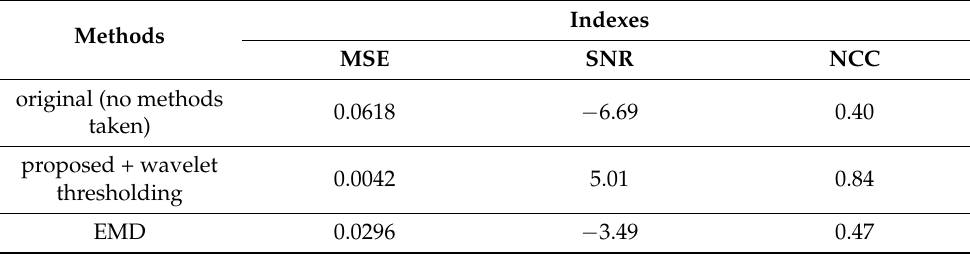
Table 4. Comparison of indexes by different methods.